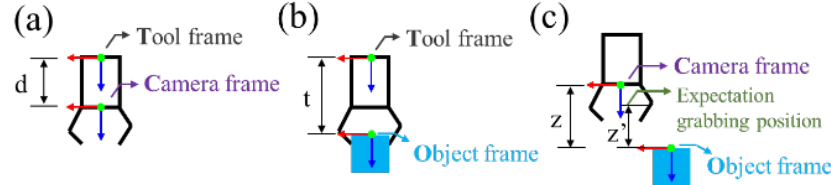
Figure 24. Parameters d, t, z, and z ′: ( a ) The distance d from tool frame to camera frame, ( b ) The distance t from tool frame to object frame, and ( c ) The distance z of camera frame to object frame, and the distance z′ from expectation grabbing position to object frame.